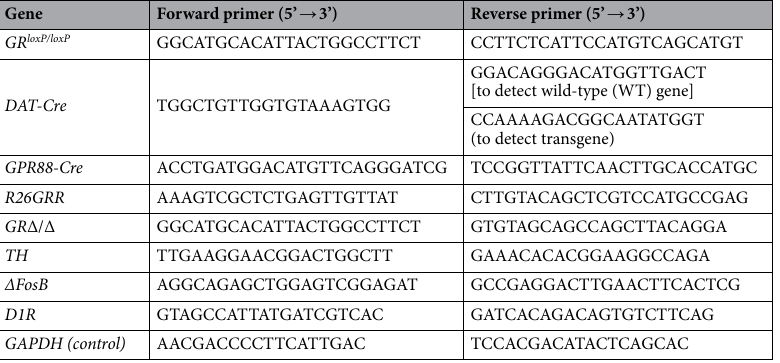
Table 1. Primers used in the present